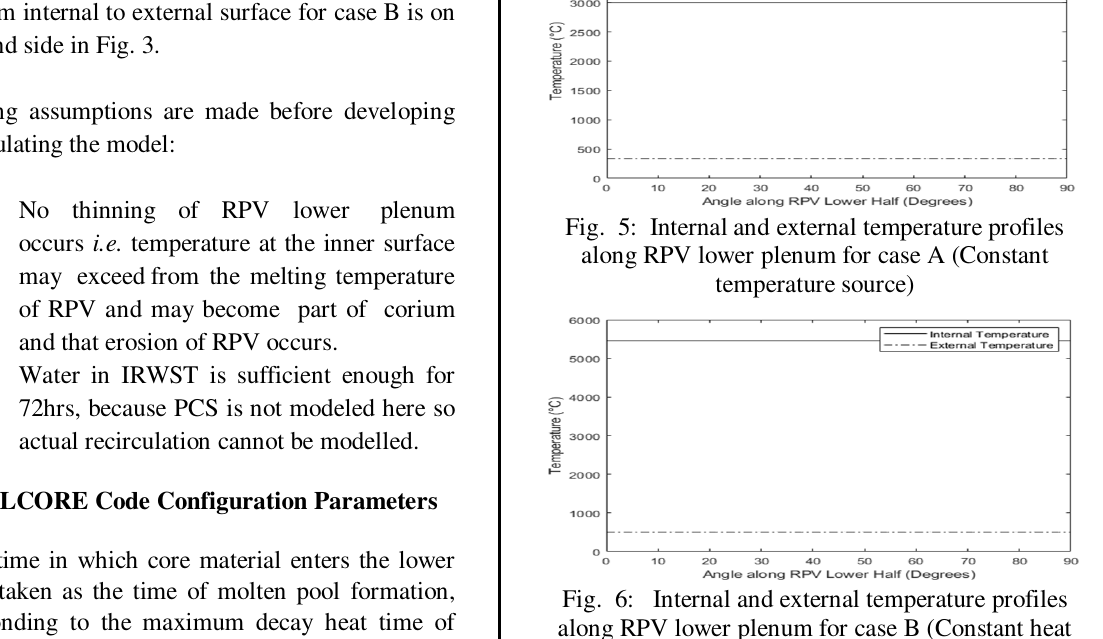
Fig. 6: Internal and external temperature profiles along RPV lower plenum for case B (Constant heat flux